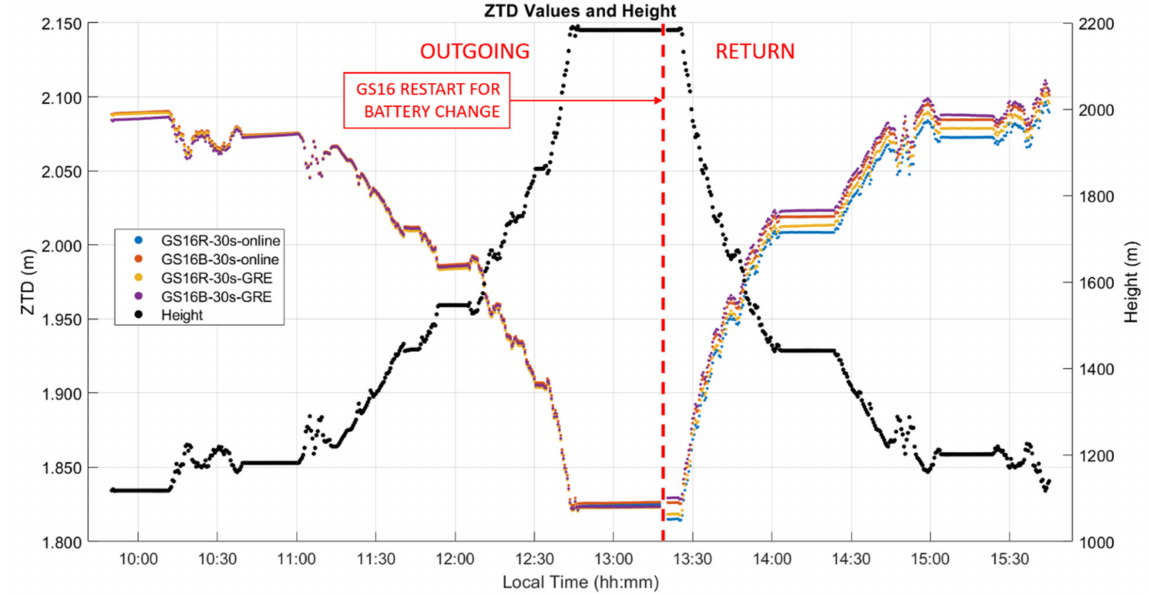
Figure 13. Kinematic dataset B PPP-derived ZTD and height profiles of outgoing and return trajectories. Local time is UTC −